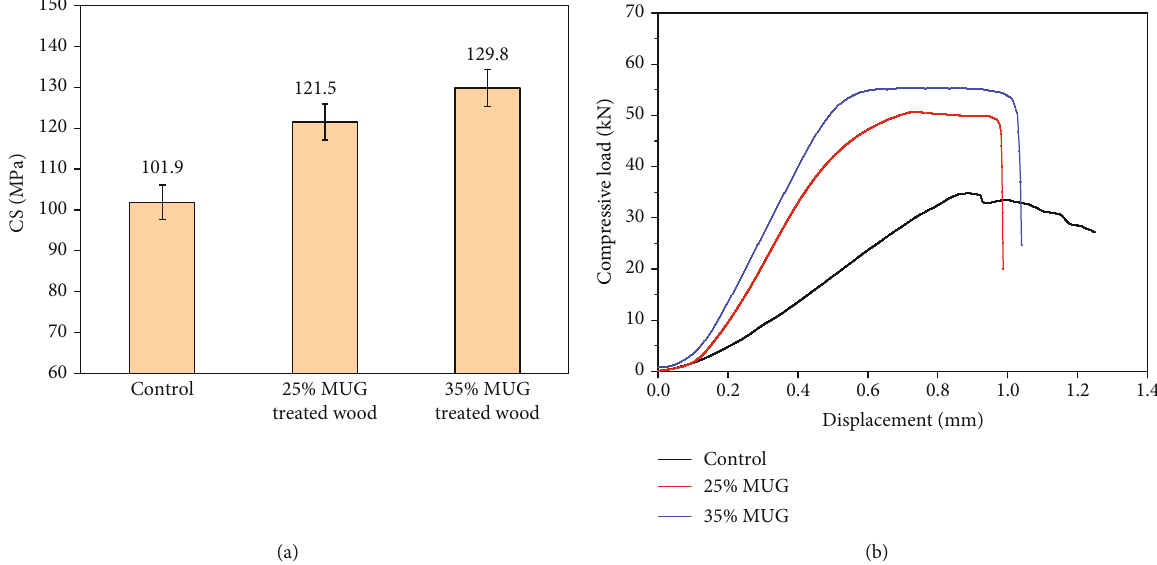
Figure 11: Compressive properties and stress-strain curves of grain of control wood, 25% MUG-treated wood, and 35% MUG-treated